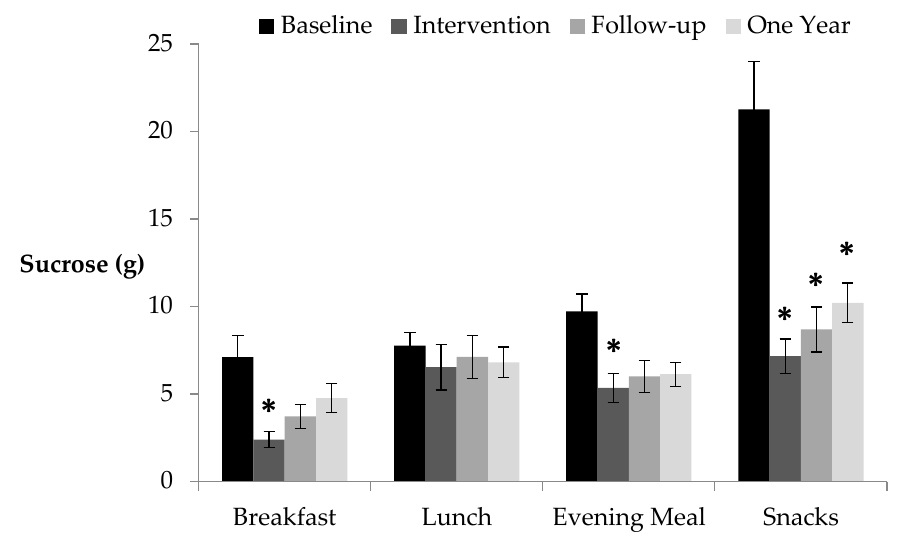
Figure 1. Sucrose consumption (g) average per child per day per meal time (se) at each two-week stage (* p < 0.05 Bonferroni corrected relative to baseline) following the Meal * Time interaction (F[9, 99] = 2.69, p < 0.01). Table 3. Significant reductions only in intake per day relative to baseline for each member of the family (Bonferroni corrected p < 0.05) (breakfast = observed change for breakfast, snack = change observed for snack, lunch = observed change for lunch, EM = change observed for evening meal). One portion of fruit and vegetables = 80 g. Mean (range) number of days data per family for each stage were 13.86 (12–14) for baseline, 13.93 (13–14) for intervention, 14 (14) for immediate follow- up, and 14 (14) for one year follow-up. * represents an increase.